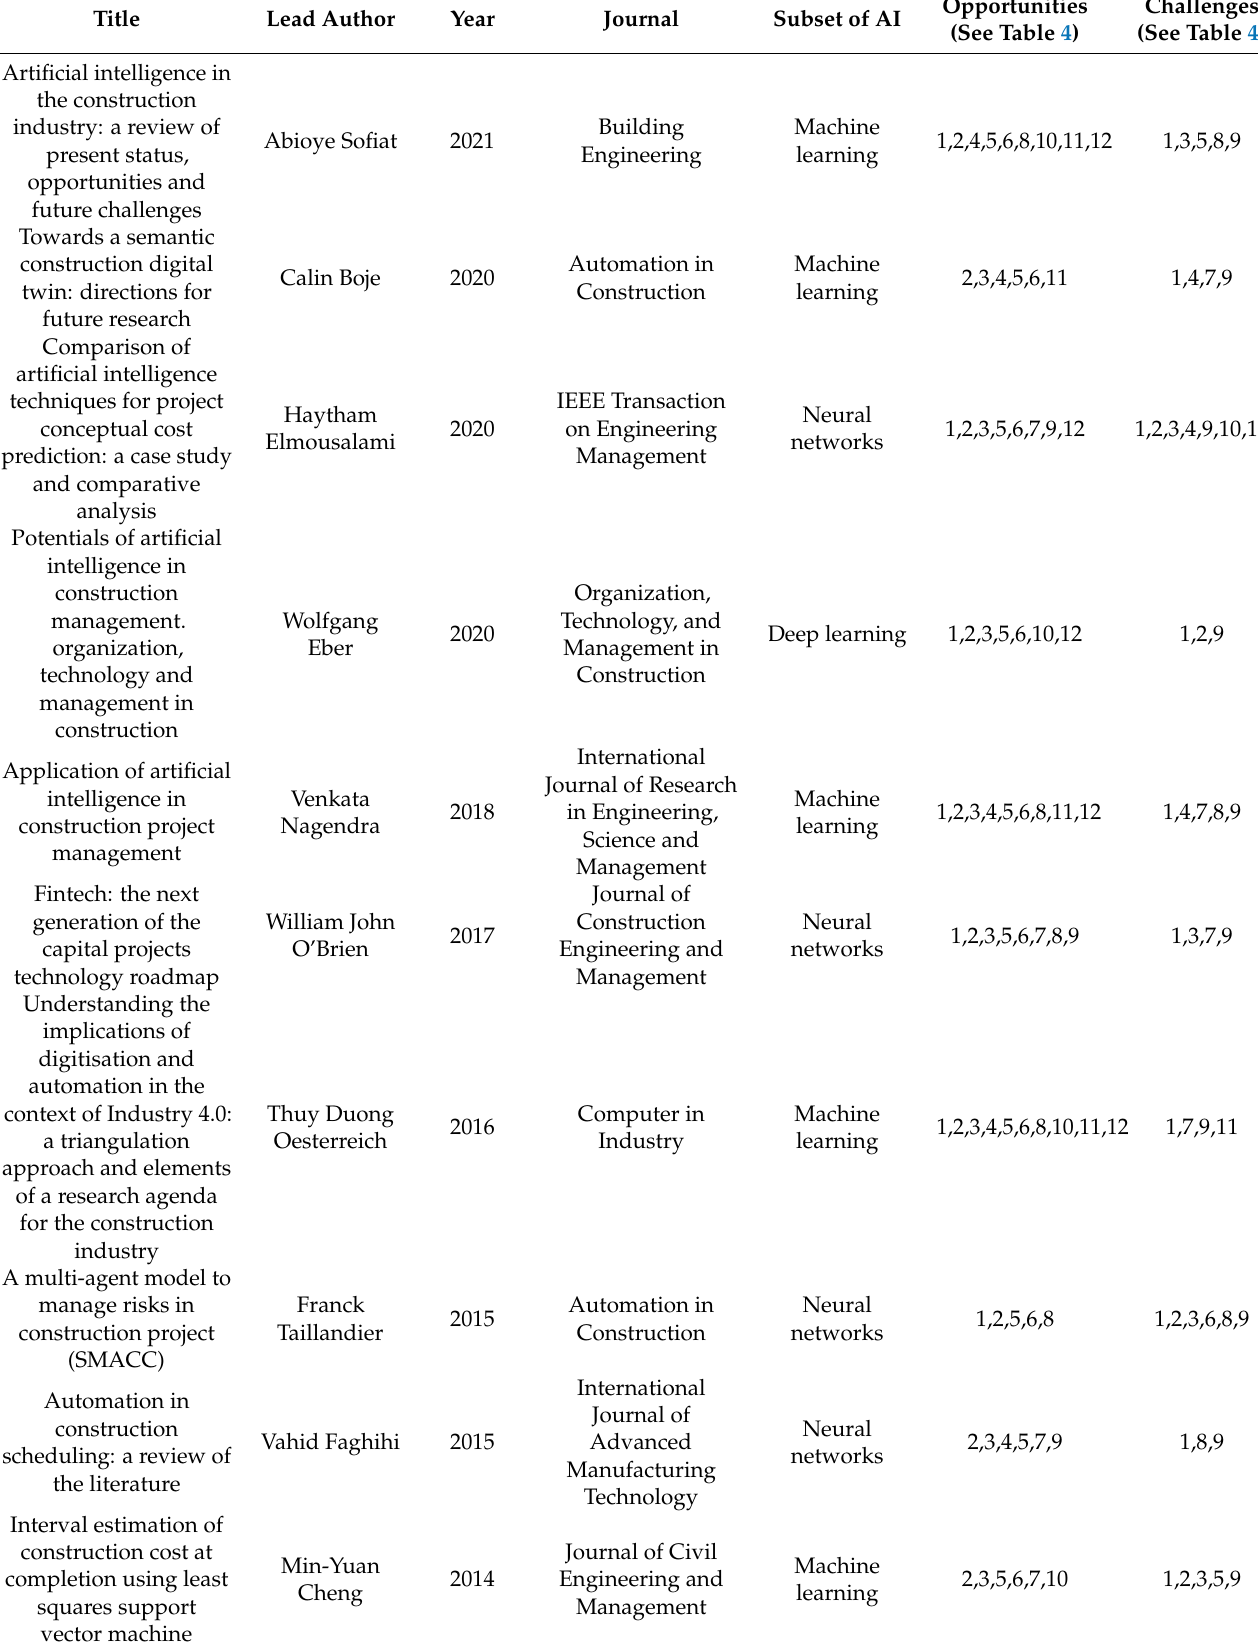
Table 5. Opportunities and challenges of adopting AI in the planning